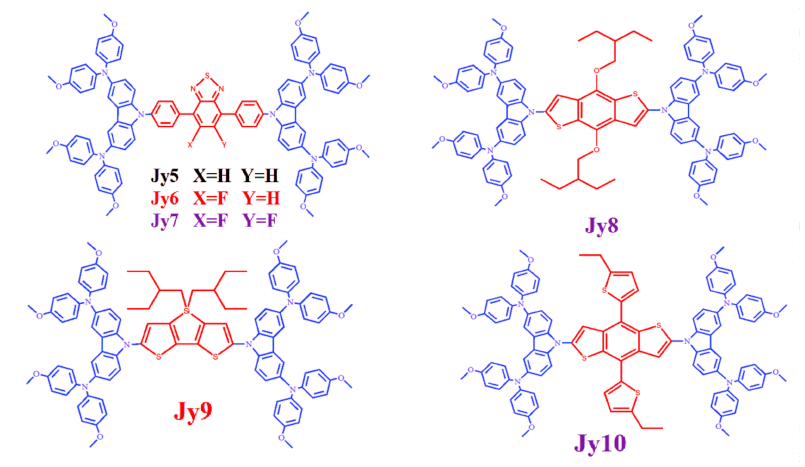
Figure 1. Chemical structures of the three experimental molecules Jy5–Jy7 and three designed molecules